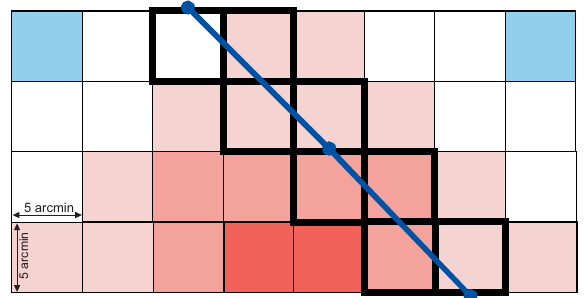
Fig. 6. Schematic representation of a reflection point ground track (line) passing over a tsunami model grid between calculated reflec- tion points (dots). Blue cells show negative, red cells show positive surface height anomalies. Those cells that are crossed by the track are marked bold. These cells are analysed if their absolute height anomaly is higher than the altimetric sensitivity assumed for the GNSS-R